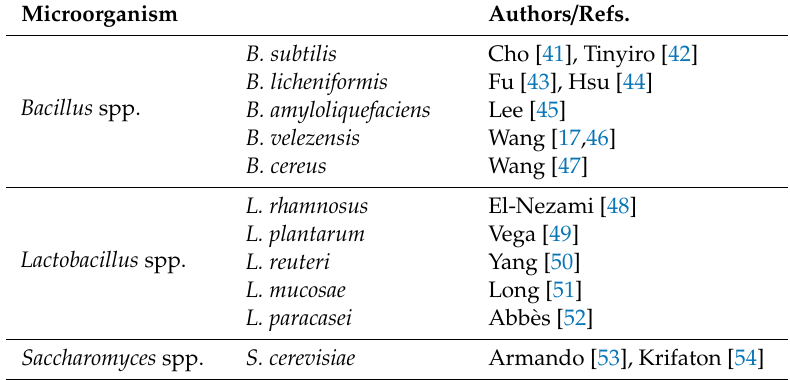
Table 1. Non-pathogenic microorganisms that can be used for the detoxification of Zearalenone